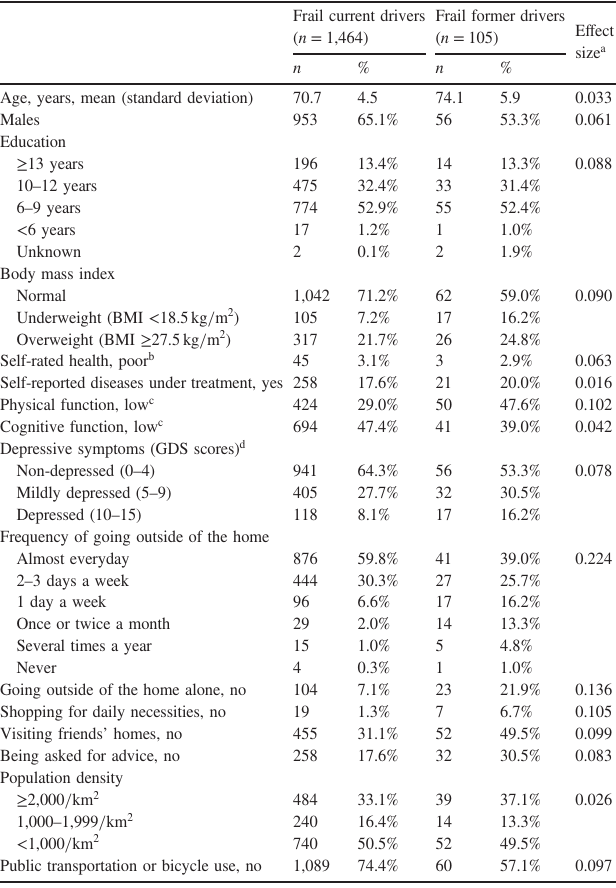
Table 1. The characteristics of current and former drivers, as of August 2010